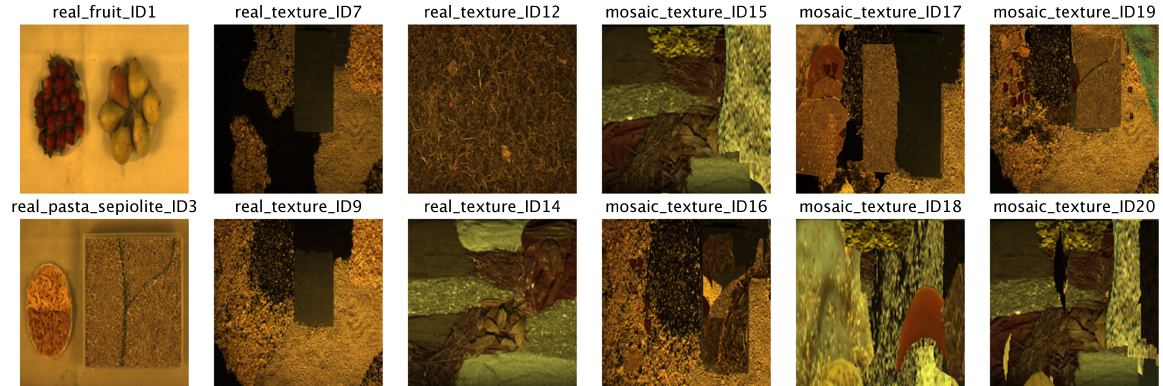
Figure 19. RGB false-color composition of hyperspectral images used in Figure 18.